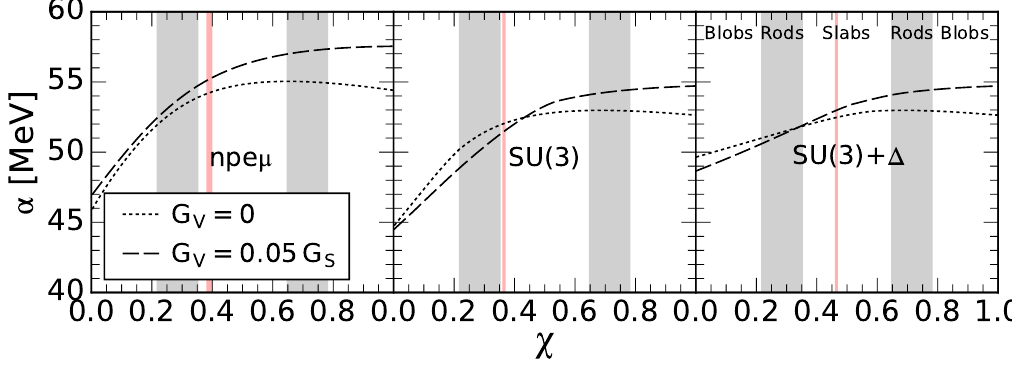
Figure 2. Surface tension α in the quark–hadron mixed phase for the DD2 parametrization [7]. The red shading indicates the range for the maximum quark fraction χ max for the two values of the quark vector coupling constant G V . (Left panel) Only nucleons and leptons are included in the hadronic phase. (Center panel) Hyperons are included in the hadronic phase. (Right panel) Delta isobars are included in addition to hyperons in the hadronic phase. Similar figures for the SWL, GM1L, and ME2 parametrizations can be found in Reference